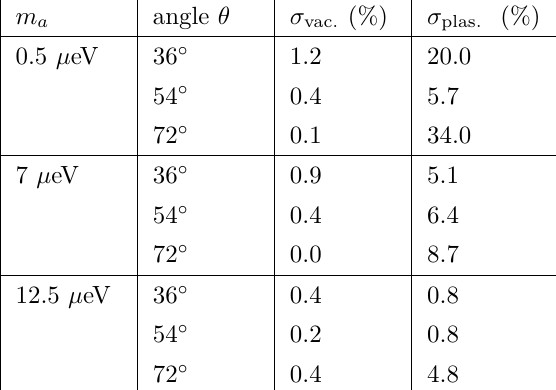
1 . Signal time-dependence. The relative time-variance of the signal σ = h ( d P /d Ω) 2 i / h d P /d Ω i 2 − 1 where h· · ·i denotes pulse averaging. The quantities σ vac . and σ plas respectively give the variance with and without plasma refraction. We displace results for